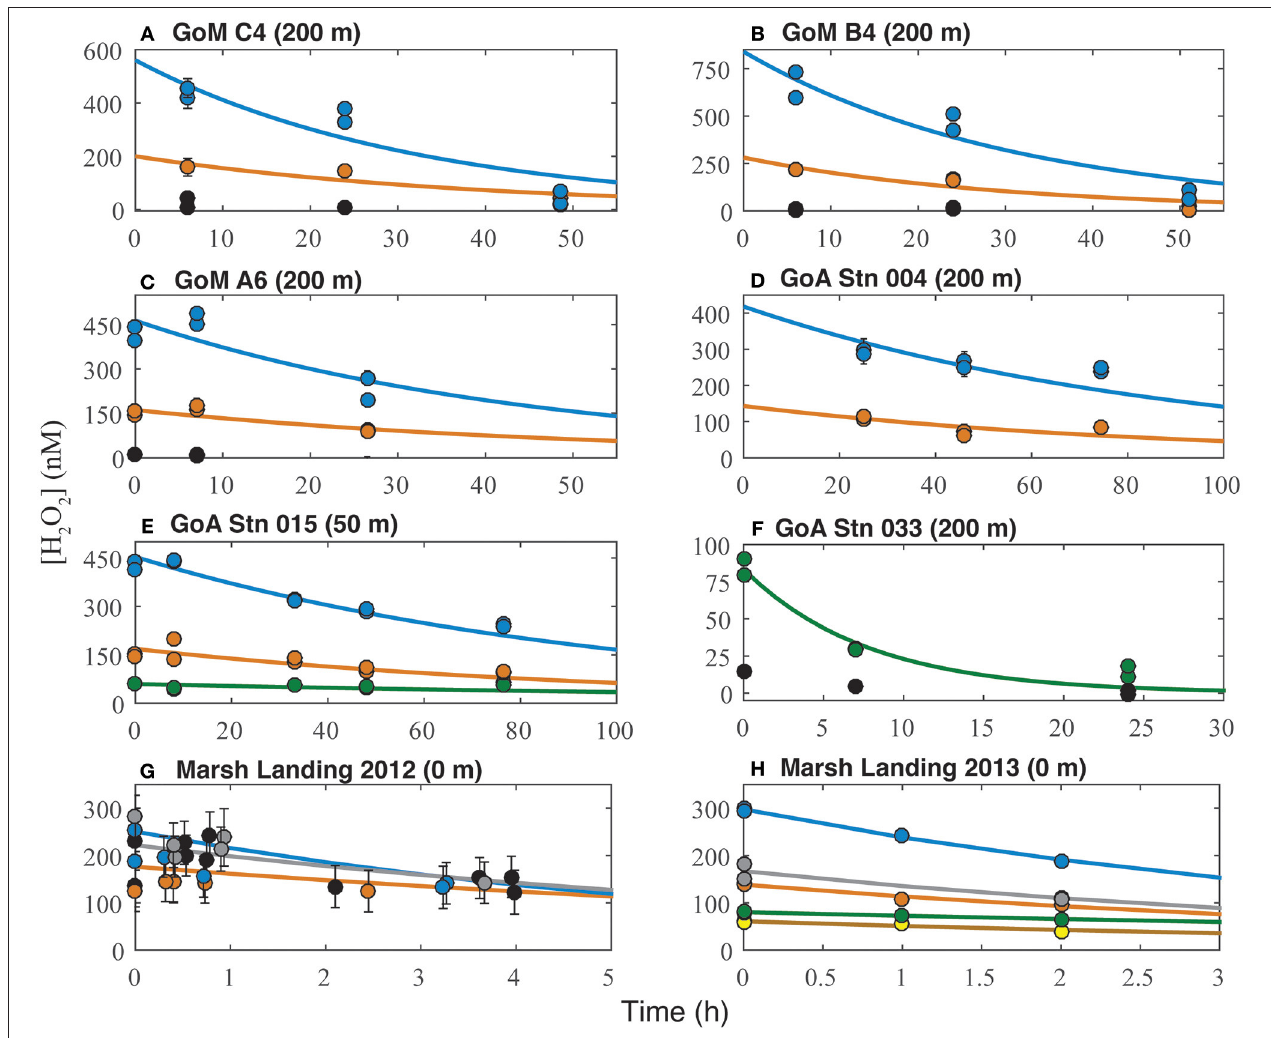
FIGURE 3 | Decay of hydrogen peroxide in ROS experiments from the Gulf of Mexico (A–C) and Gulf of Alaska (D–F) in control (black), 30nM H 2 O 2 (green), 100nM H 2 O 2 (orange), and 300 nM H 2 O 2 (blue) incubations; and Marsh Landing 2012 (G) and 2013 (H) in control (black), 10 nM H 2 O 2 (yellow), 30nM H 2 O 2 (green), 100 nM H 2 O 2 (orange), 300 nM H 2 O 2 (blue), and rain (gray) incubations. Symbols represent measured H 2 O 2 concentrations, while curves represent modeled decay rates; all panels contain error bars representing standard deviation from the mean (note that in some cases error bars are too small to be seen outside of